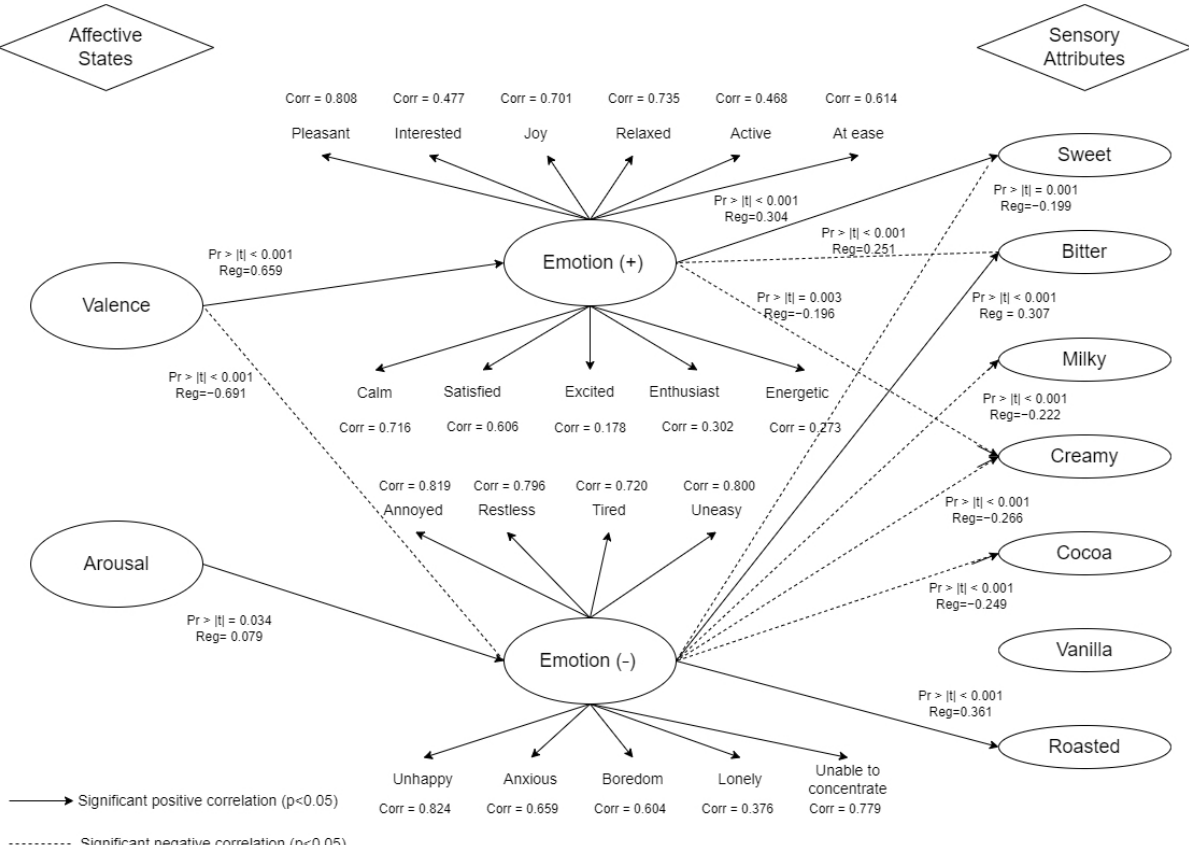
Figure 5. PLS-PM showing only the significant correlations between affective responses, self-rated emotion measures, sensory attributes, and perceptual correlates. To aid visualisation, positive correlations are indicated with continuous lines, and negative correlations with dashed